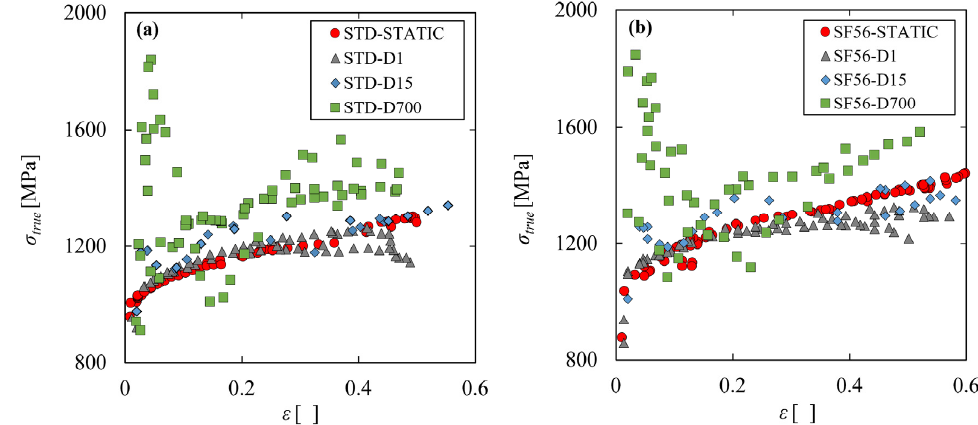
Figure 5. Experimental true stress–strain curves at different strain rates with the standard ( a ) and SF56 ( b ) parameter sets. SF56 ( b ) parameter sets.